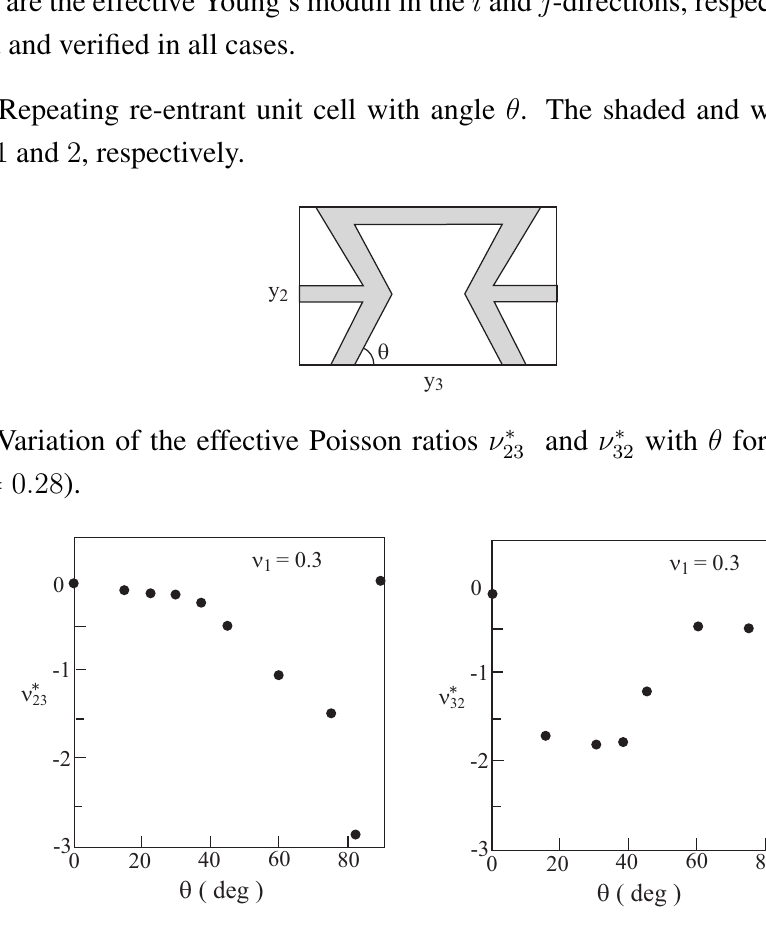
Figure 2. Repeating re-entrant unit cell with angle θ . The shaded and white regions are labeled by 1 and 2 , respectively.